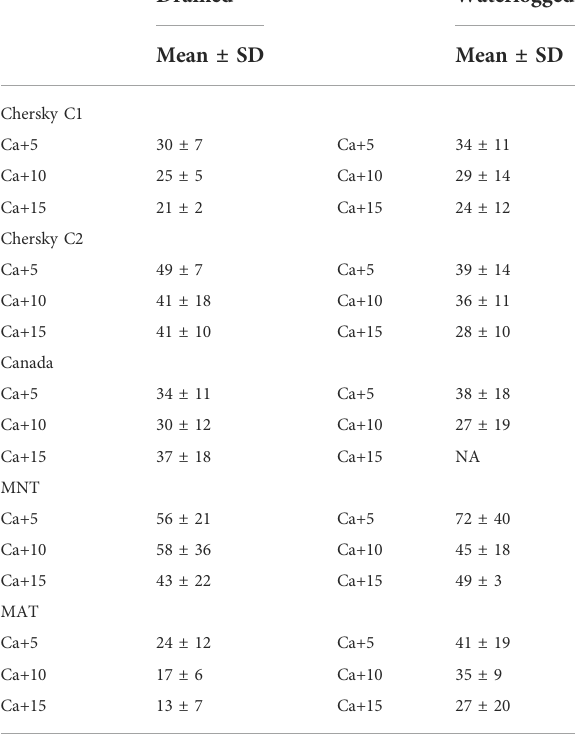
TABLE 3 CO 2 production for the different soils and Ca treatments compared to the control treatment in % difference from the treatment